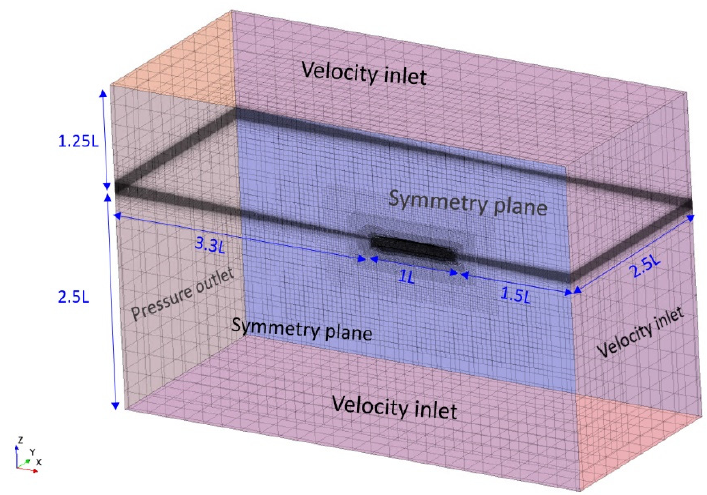
Figure 4. Computational domain and the boundary conditions of the Wigley hull simulation.